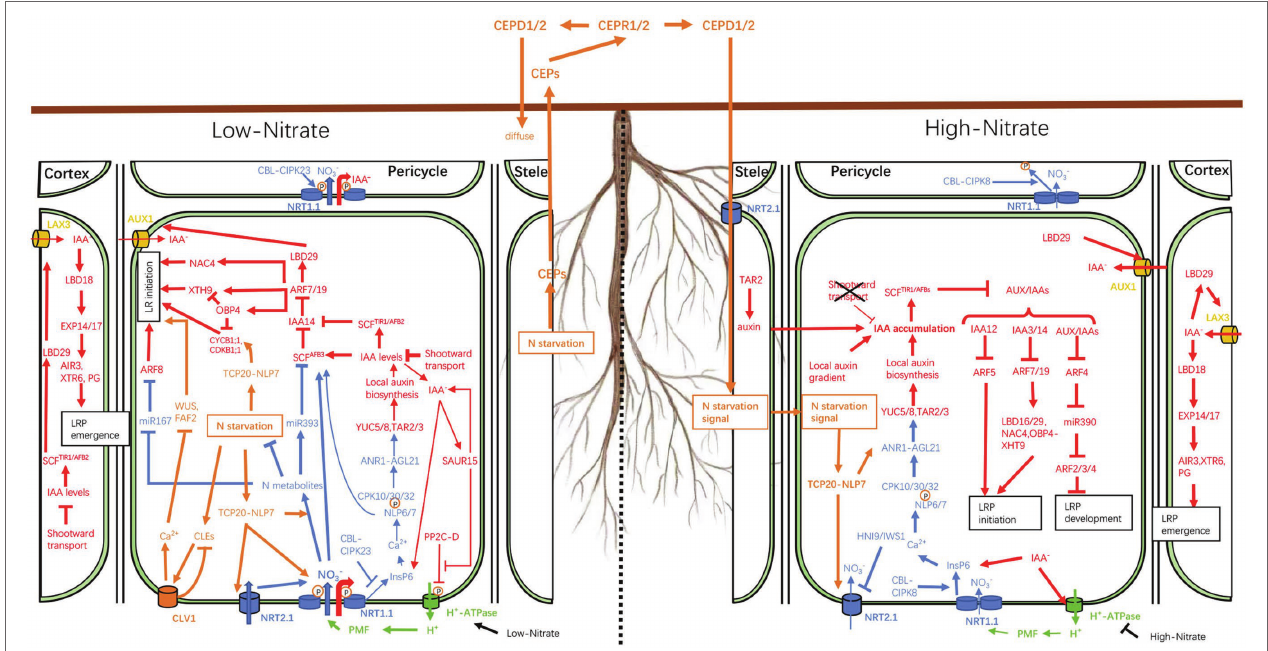
FIGURE 1 | Schematic representation of the nitrate–auxin crosstalk under heterogeneous nitrate availability. When the external nitrate concentration is low (<0.05 mM), phosphorylated NRT1.1, a high-affinity nitrate transporter, transports large amounts of nitrate into cells to alleviate the effects of internal nitrogen deficiency. NRT1.1, located on epidermal cells, also acts as an auxin transporter to facilitate shootward auxin transport, thereby reducing lateral auxin reflux and auxin accumulation in pericycle cells, resulting in the inhibition of lateral root (LR) initiation. When NRT1.1 is phosphorylated, its nitrate sensor function is inhibited. Consequently, the low level of local auxin biosynthesis, regulated by ANR1, cannot offset the loss of auxin. In addition, nitrate ions (NO 3 − ) transported into cells can participate in the regulation of auxin-mediated LR formation through the miR393-AFB3 module. When the external nitrate concentration is high (>10 mM), NRT1.1 is dephosphorylated and functions mainly as a nitrate sensor to stimulate LR growth. The N starvation status signals of roots in low-NO 3 − regions are transmitted to high-NO 3 − regions through the CEP-CEPR1/2-CEPD1/2 module. Different from the demand for nitrate transport in low-NO 3 − areas, in high-NO 3 − areas, the TCP- NLP7 dimer is retained in the nucleus, where it acts to increase the sensitivity of the primary nitrate response (PNR). Lines ending in an inverted T ( ⊥ ) indicate negative regulation while line thickness indicates the strength of the pathways. Local nitrate, systemic nitrate, and auxin responses are shown in blue, yellow, and red, respectively. The protonmotive force (PMF) is shown in